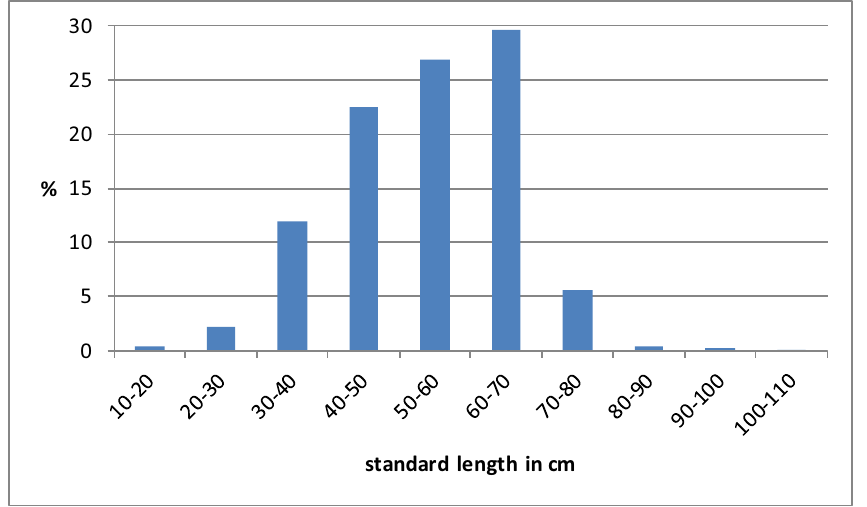
Fig 7. The reconstructed fish lengths of the Clarias catfish, presented in 10 cm size classes. Total sample size was 4505 specimens.